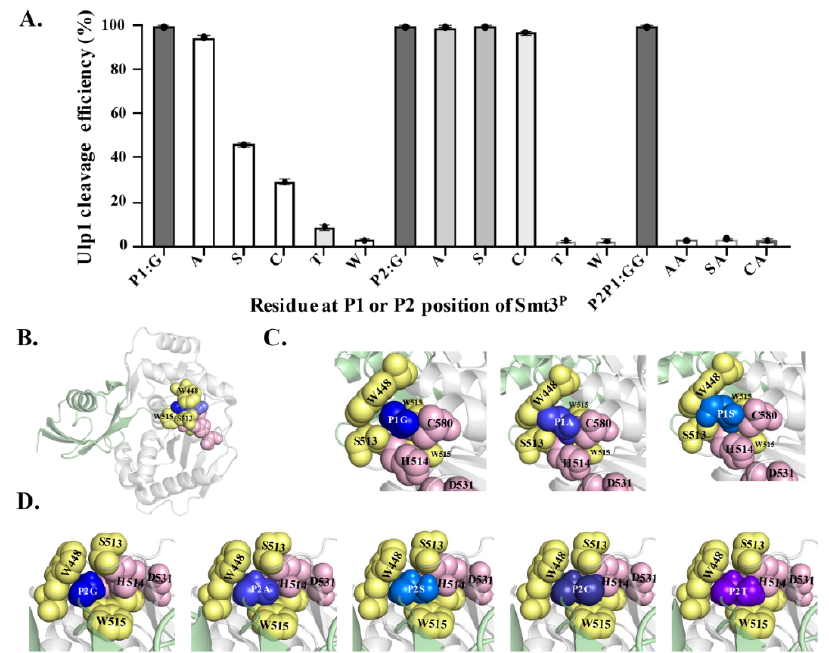
Figure 4. Analyzing the residue specificity of Ulp1 against Smt3 at P1 and P2 positions. ( A ) Gly–Gly at P1 and P2 position of Smt3 were mutant to arbitrary amino acids (GX 1 ↓ , X 2 G ↓ and X 2 × 1 ↓ ), with the mutant alleles named Smt3 P . Cleavage efficiency of Ulp1 against Smt3 P alleles are presented as average cleavage efficiency ( n = 3 independent experiments). ( B ) Structure of Ulp1–Smt3 complex (PDB, 1euv). Grey represents protease Ulp1 whose substrate pocket is jointly-constructed by catalytic triad C580–H514–D531(pink) and residues of W448, S513 and W515 (yellow). Light green represents Smt3, and purple and blue represent Gly at P1 and P2 position, respectively. ( C ) Structural